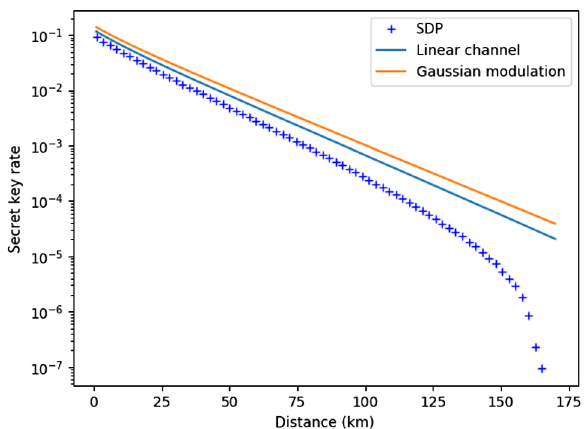
FIG. 2. Secret key rate versus distance, for a Gaussian channel with transmittance T ¼ 10 − 0 . 02 d and excess noise ξ ¼ 0 . 002 . Here, d is the distance between Alice and Bob in km. The value of α is 0.35. The reconciliation efficiency β is set to 0.95. The top curve corresponds to the performance of the protocol [39] with a Gaussian modulation, the lower curve to the performance of the four-state protocol while assuming a linear channel (as in Ref. [26]), and the crosses correspond to the lower bound given by our